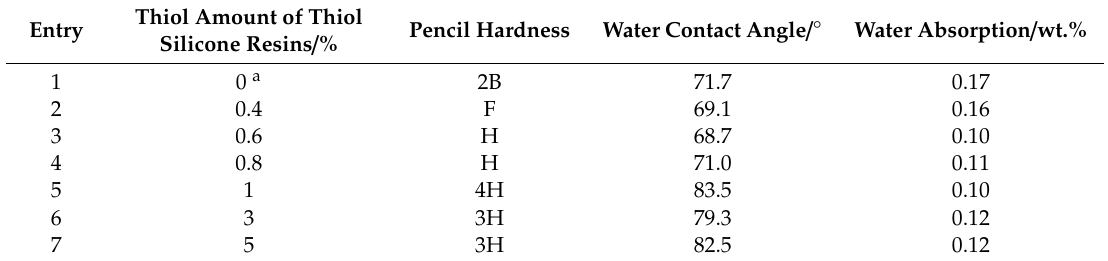
Table 4. Impact of the amount of thiol silicone resin on the